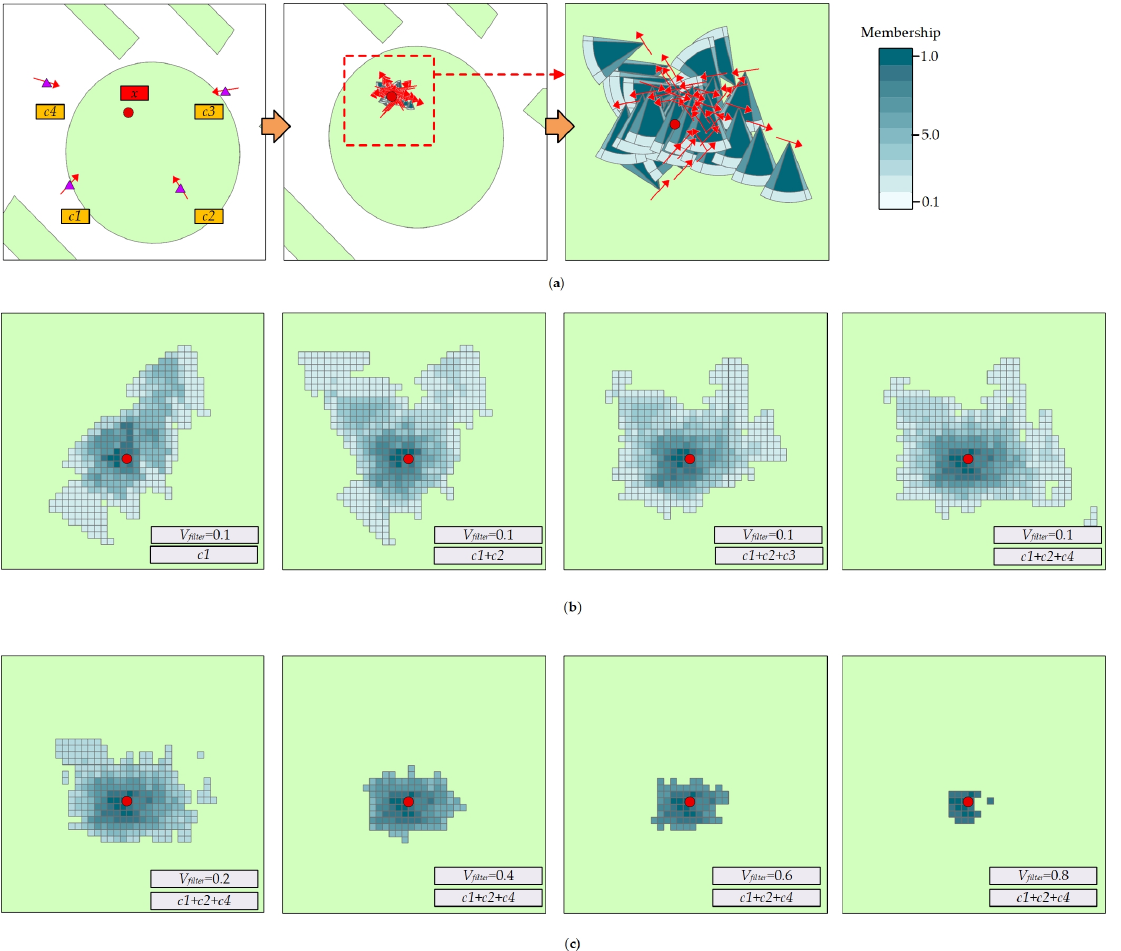
Figure 9. Results after introducing multiple descriptions: ( a ) Four added descriptions and result; ( b ) four descriptions’ R result are gradually merged into R union ; ( c ) the influence of V filter .